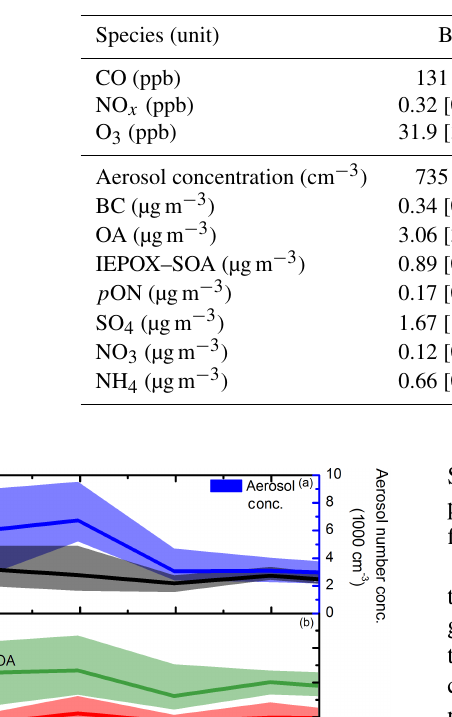
Table 2. Mean and lower and upper 95% confidence interval of mean for different species under background and in-plume conditions for ATR42 flight trajectories below 2000m.